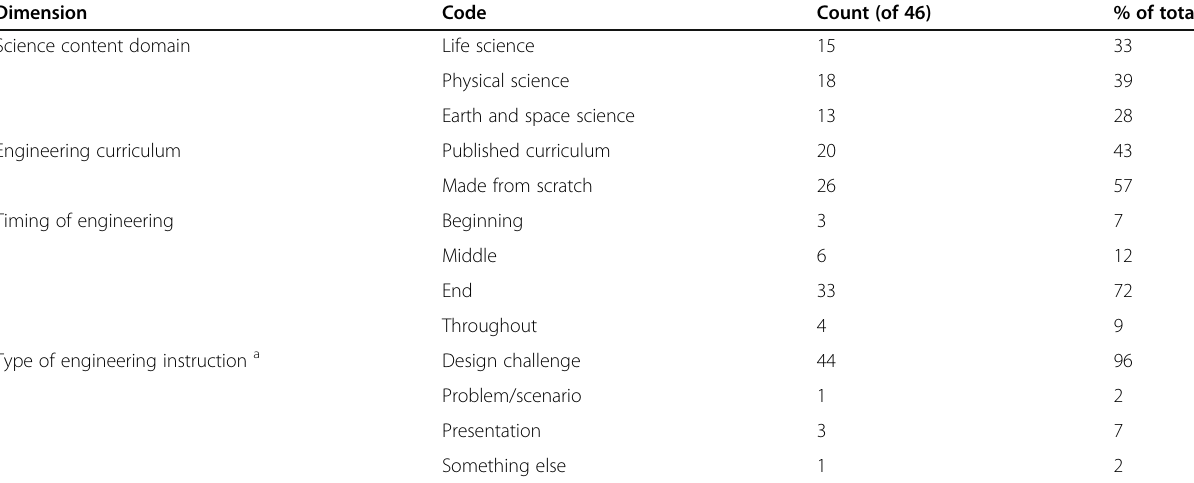
Table 5 Descriptive codes assigned to unit